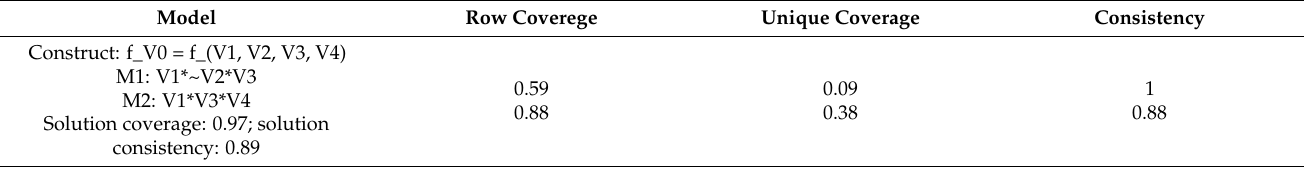
Table 6. Technology entrepreneurship configurations of high-performing RDF producers in Poland. Model Row Coverege Unique